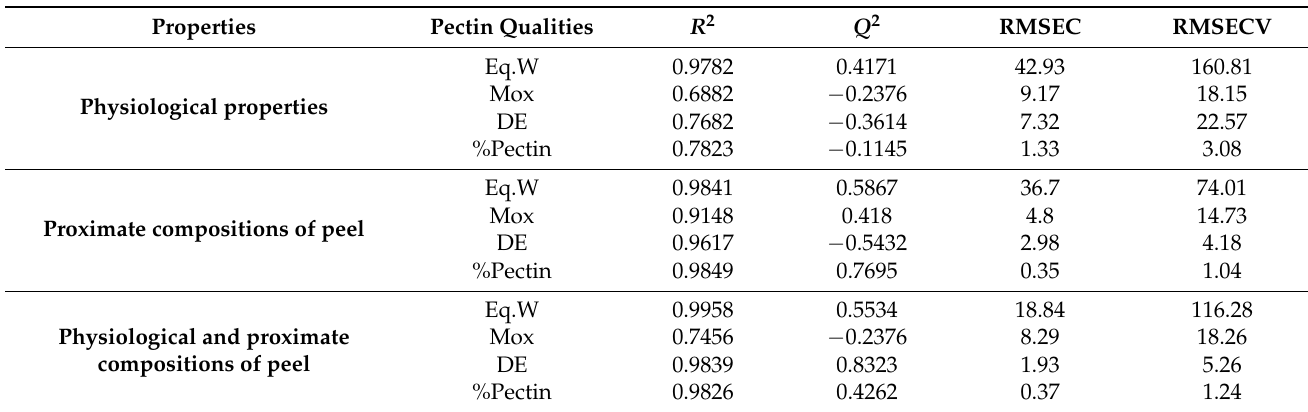
Table 5. R 2 and Q 2 values with their error scores obtained from the correlation graph of the expected and predicted pectin quality values with fruit physiological properties and nutritional compositions of peel using the PLS